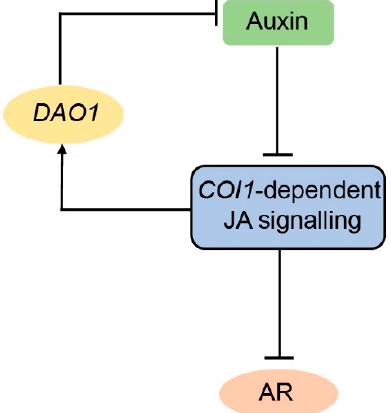
Figure 5. DAO1 controls a feedback circuit to stabilize IAA–JA crosstalk during ARI. Auxin promotes ARI by modulating the homeostasis of the negative regulator JA. COI1-dependent JA signaling induces the expression of DAO1, which in turn controls the thresholds of IAA by irreversible degradation. Arrows indicate positive regulation, whereas dashes indicate negative regulation.